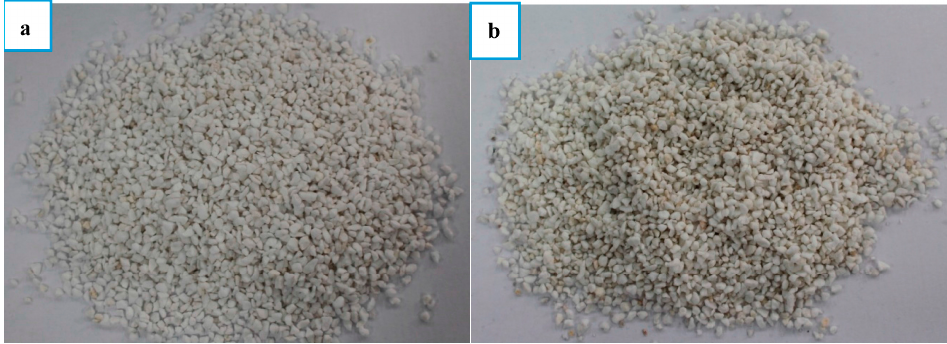
Figure 8. Images of: EP ( a ); and TD-LA/EP ( b ).